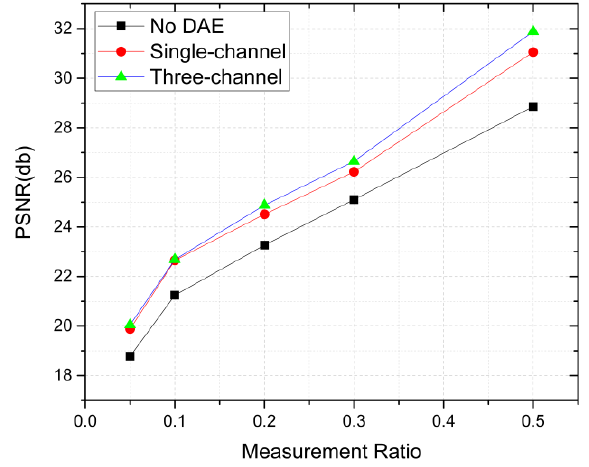
Figure 11. PSNR values of test pictures at different measurement rates when DPAP uses different channel denoising autoencoders. Table 3. PSNR of 5 test images when DPAP uses different channel denoising autoencoders at different measurement